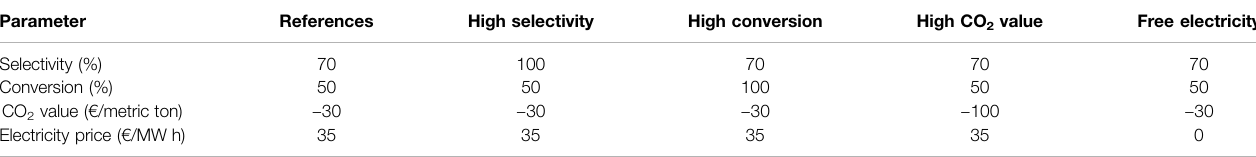
TABLE3| Valuesforthethreeinputparameters,i.e.,productselectivity(%),conversion(%),CO 2 value( € /metric ton)andelectricityprice( € /MW h)forthe fi vedifferentcases. Parameter